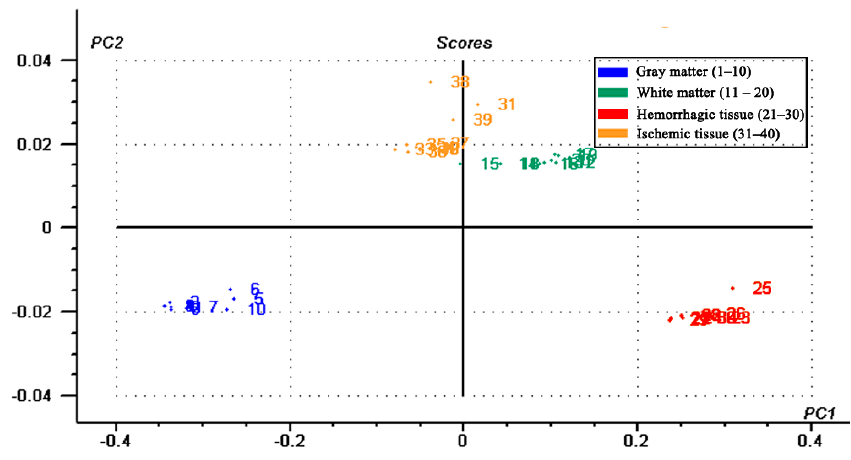
Figure 7. Principal component analysis score plot from the partial least squares discriminant analysis showing the first two principal components.